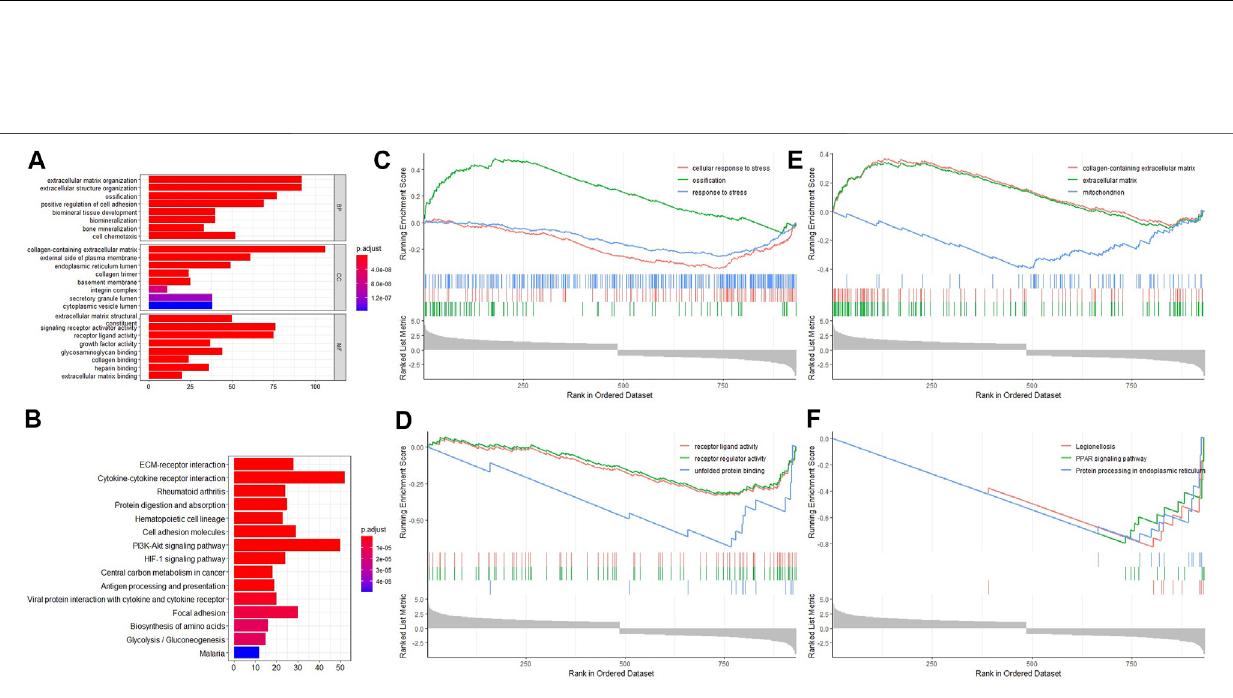
FIGURE 2 | Enrichment analyses for differentially expressed lncRNAs and differentially expressed mRNAs. (A) GO enrichment analysis. (B) KEGG signaling pathway enrichment analysis. (C) GSEA biology process enrichment analysis. (D) GSEA molecular function enrichment analysis. (E) GSEA cell component enrichment analysis. (F) GSEA KEGG signaling pathway enrichment